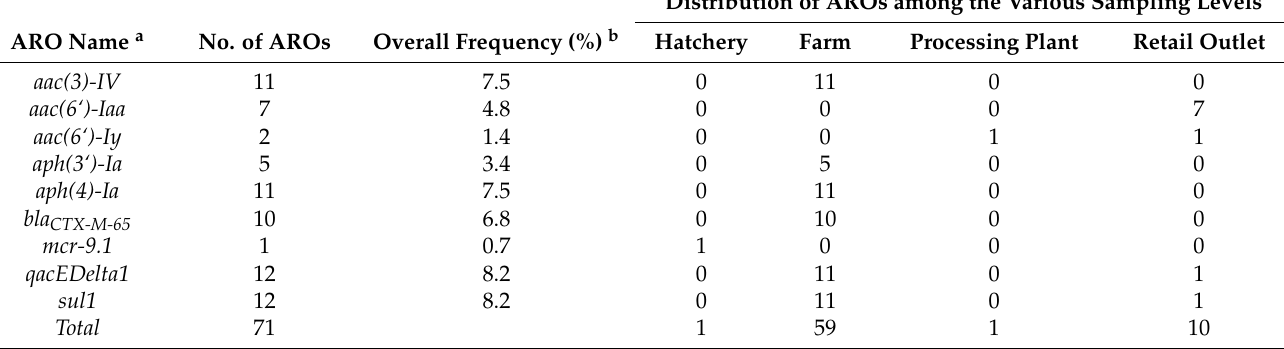
Table 3. Frequency of ARO accessions detected in this study. Distribution of AROs among the Various Sampling